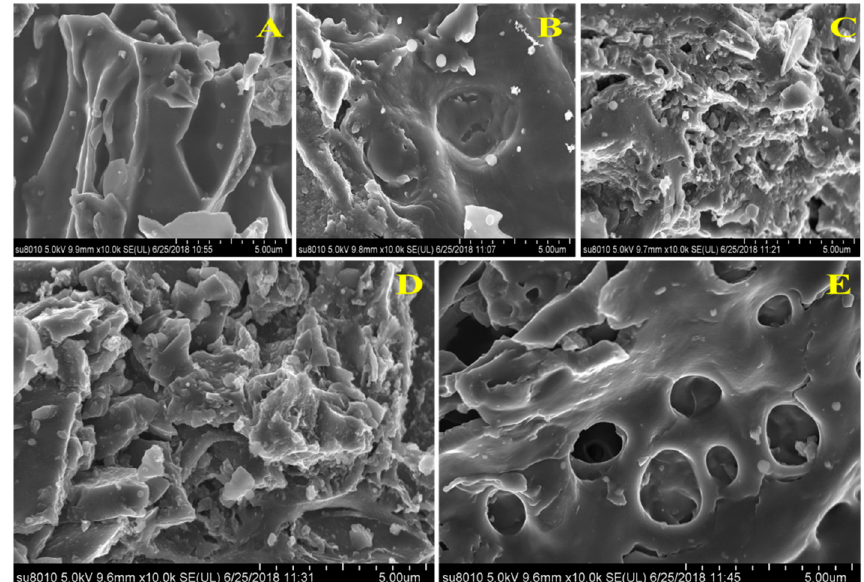
Figure 2. Scanning electron microscopy images of the five biochar samples. ( A , B , C , D , E ) represent the images for PBC, H 2 O-PBC, HCl-PBC, H 2 SO 4 -PBC and H 2 O 2 -PBC, respectively.